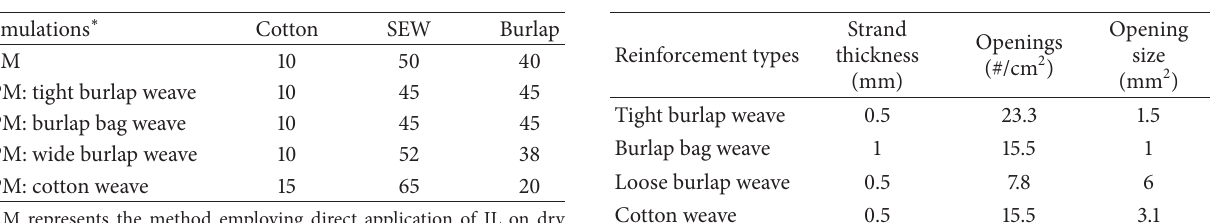
Table 1: Weight percentages in test formulations.